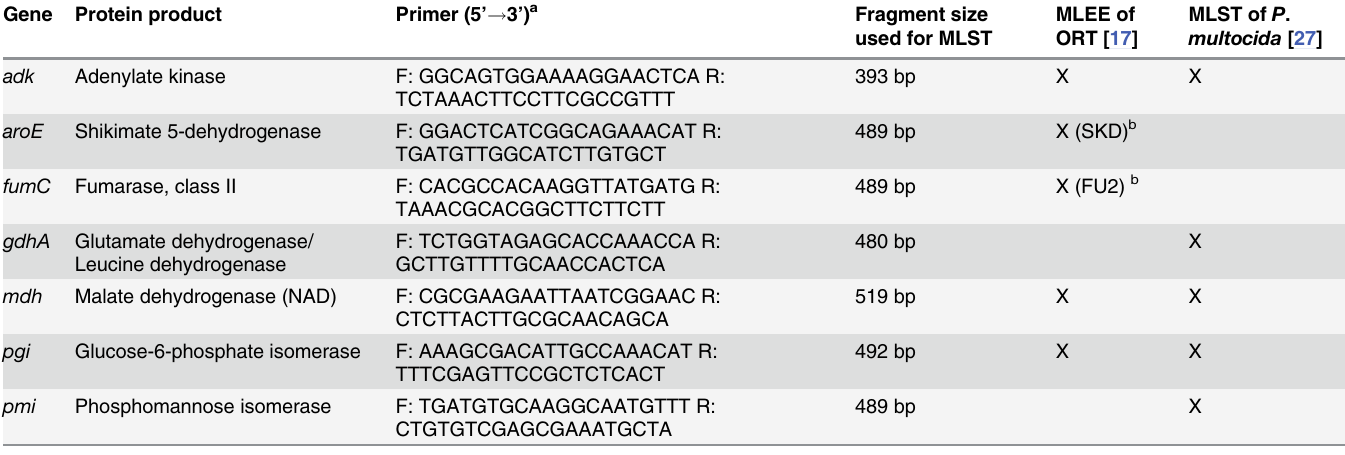
Table 2. Housekeeping genes, primers and corresponding gene fragments used for multilocus sequence typing of Ornithobacterium rhinotracheale . Gene Protein